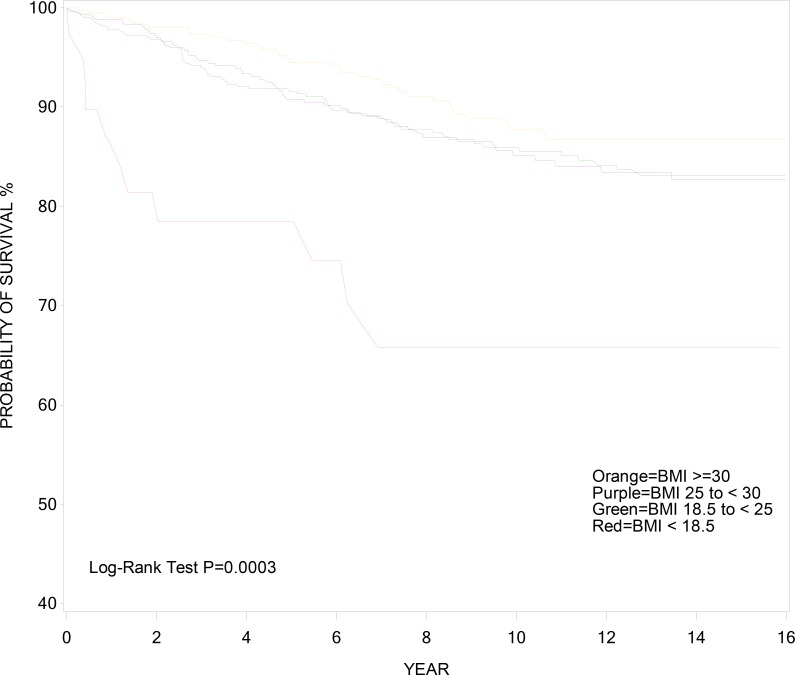
Cumulative Incidence of AIDS Survival.